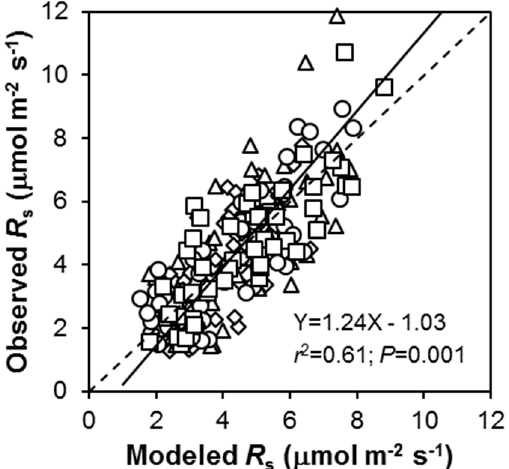
Figure 5. Relationship between observed soil respiration ( R s ) and R s modeled from temporal variations in soil water content and soil temperature. Different symbols are used to distinguish between vigorous (squares), slightly affected (diamonds), severely affected (triangles) and dead (circles) trees, but a single regression model is given for all tree-decline classes pooled for clarity. The major axis regression analysis was used to analyze the relationship between the observed and the modeled R s . Dotted line depicts the 1:1 line.